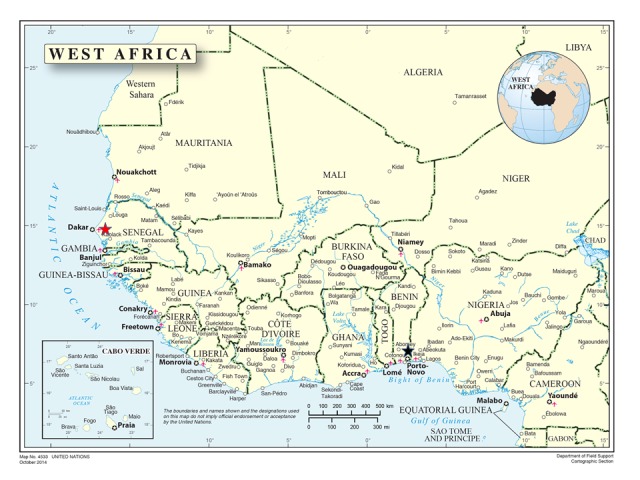
Map of West Africa (United Nations 2014).